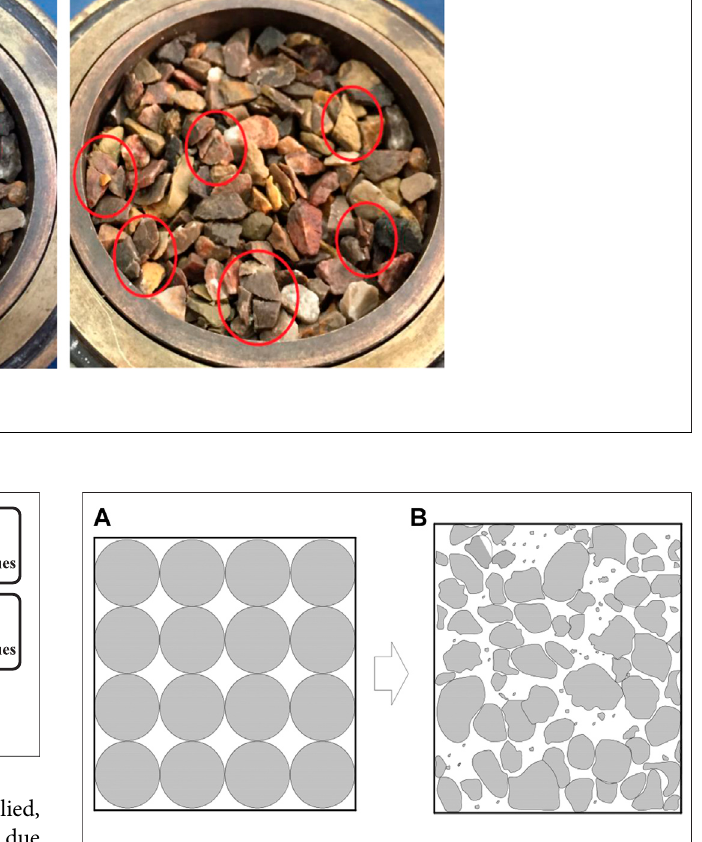
FIGURE 10 | Coarse specimen stages during consolidation test. (A) Coarse specimen before consolidation; (B) coarse specimen after consolidation.